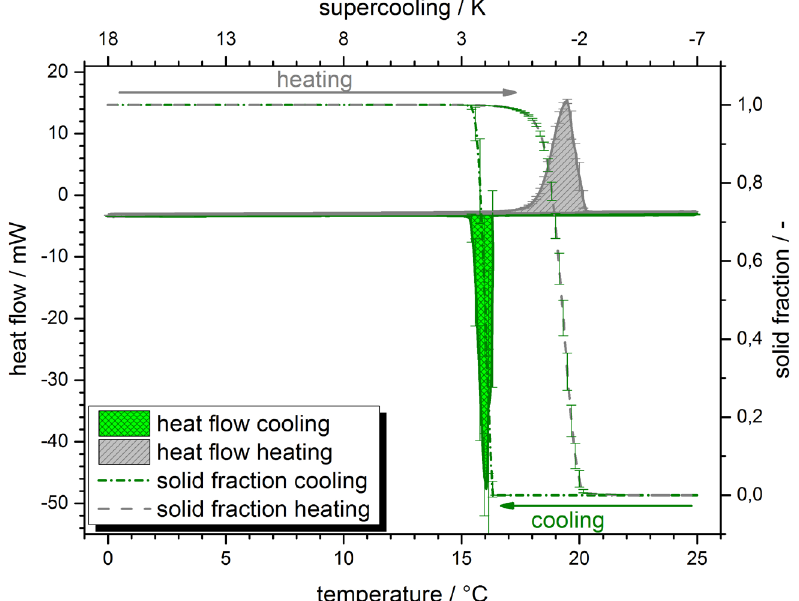
Figure 3. Differential scanning calorimetry (DSC) measurements of bulk hexadecane. Cooling from 25 to 0 ◦ C with cooling rate of 1 K/min: the grid area is the integral of the cooling curve with the dot chain line for solid fraction as a function of temperature during cooling. Heating from 0 to 25 ◦ C with heating rate of 1 K/min: hatched area is the integral of the heating curve with the dash line for solid fraction as a function of temperature during heating.